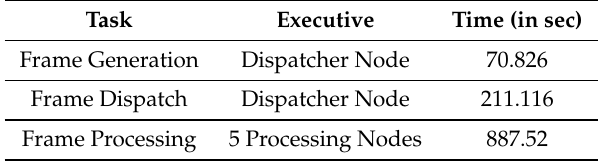
Table 6. Average video processing performance of six-node ad hoc